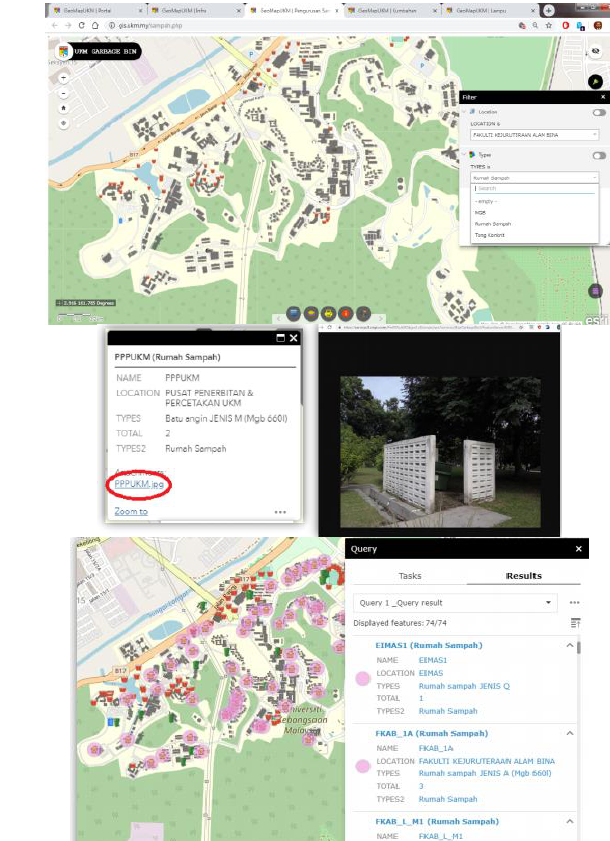
Figure 13. Waste and garbage bin